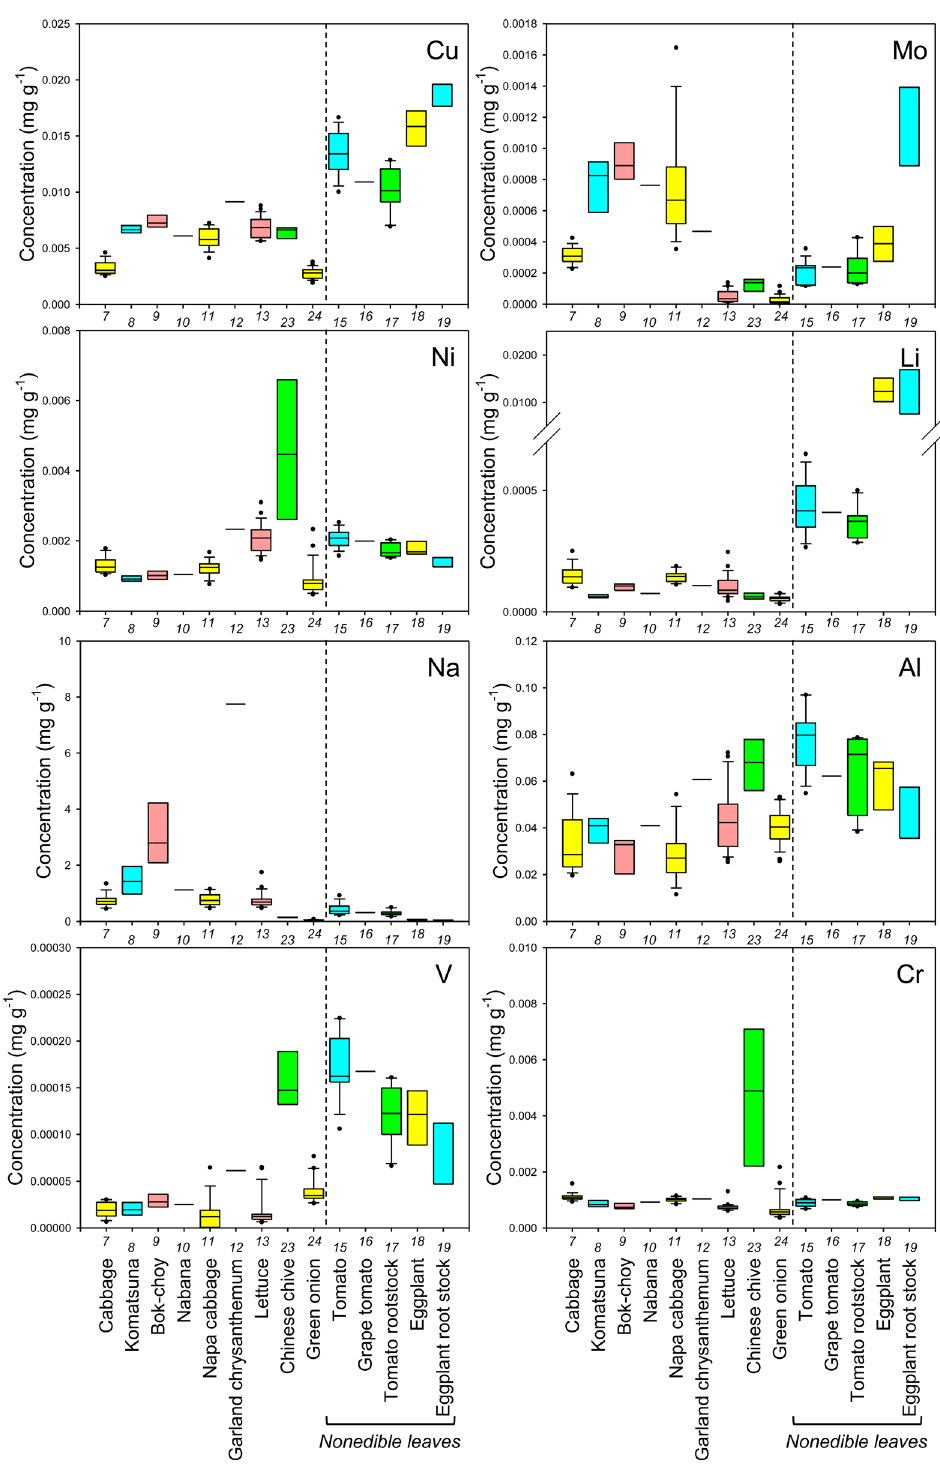
Fig 2. Boxplots showing the concentration of Cu, Mo, Ni, Li, Na, Al, V, and Cr in leaves of various crop species. Concentrations in nonedible leaves are also shown. Numbers in x-axis indicate the species number in Table